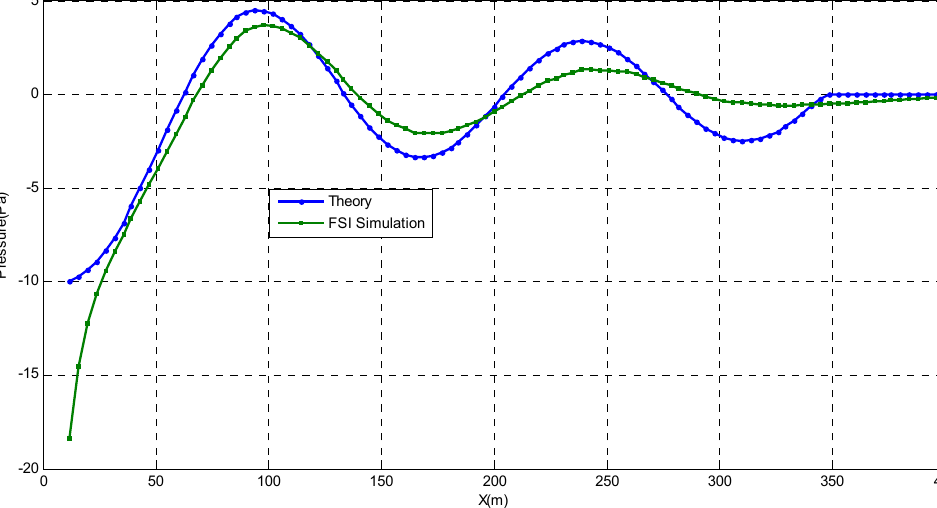
Figure 15. Pressure at the position, L-1, when t = 1.0 s.